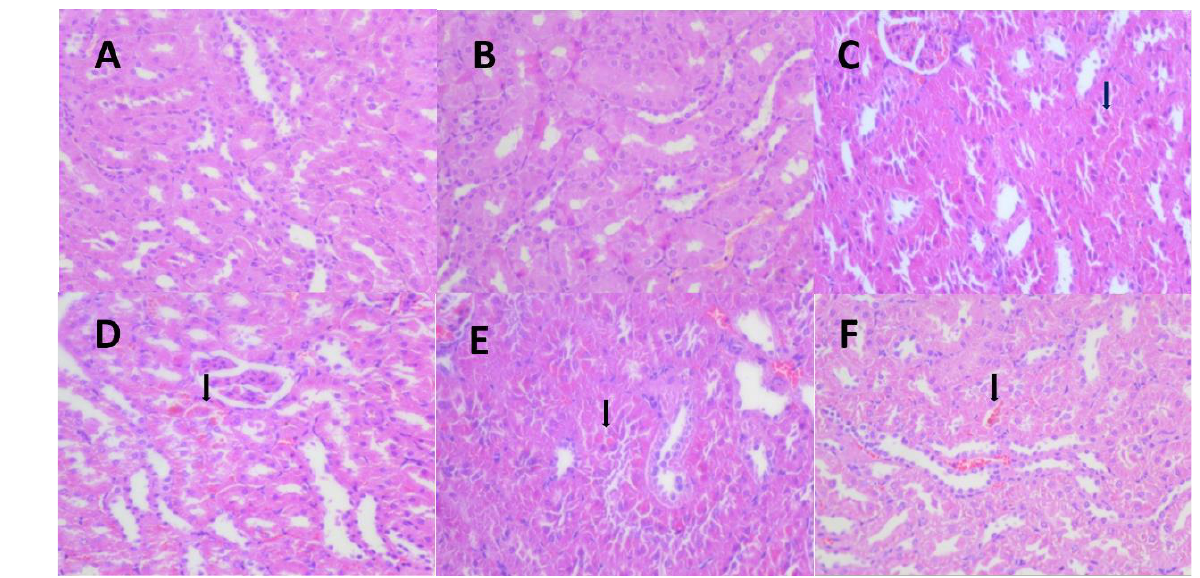
Figure 4. Representative images of the pathological changes in the Hyaline droplet (arrow) of the kidney tissue in each dose group and the control group at 13 weeks. ( A ) (HE 40 × 10, control group, normal kidney), ( B ) (HE 40 × 10, 1.36 mg/kg group, normal kidney), ( C ) (HE 40 × 10, 1.36 mg/kg group, minimalhyaline droplets in the kidney), ( D ) (HE 40 × 10, 5.44 mg/kg group, mild hyaline droplets in the kidney), ( E ) (HE 40 × 10, 21.76 mg/kg group, mild hyaline droplets in the kidney), ( F ) (HE 40 × 10, 174.08 mg/kg group, mild hyaline droplets in the kidney). The hyaline droplet accumulation of the kidney of the rats was then further graded and evaluated, with the degree of lesions starting at 5.44 mg/kg BW significantly higher in the females and males than in the controls at the end of the administration. No hyaline droplet accumulation of the kidney was observed in the females at 1.36 mg/kg BW, and hyaline droplet accumulation of the kidney was observed in the males at 1.36 mg/kg BW, but there was no significant difference when compared to the control group (Table